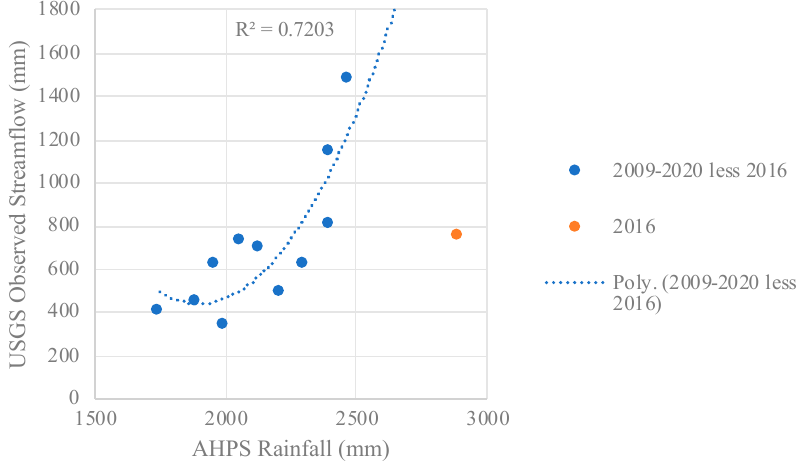
Figure 11. USGS observed streamflow vs. AHPS rainfall for 2009–2020.